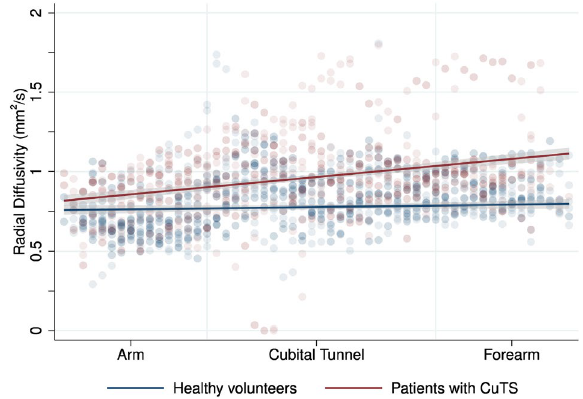
Figure 3. Scatter plot with linear fit (and 95% CI) showing the relationship between radial diffusivity of the ulnar nerve in volunteers and patients, at different positions within the upper